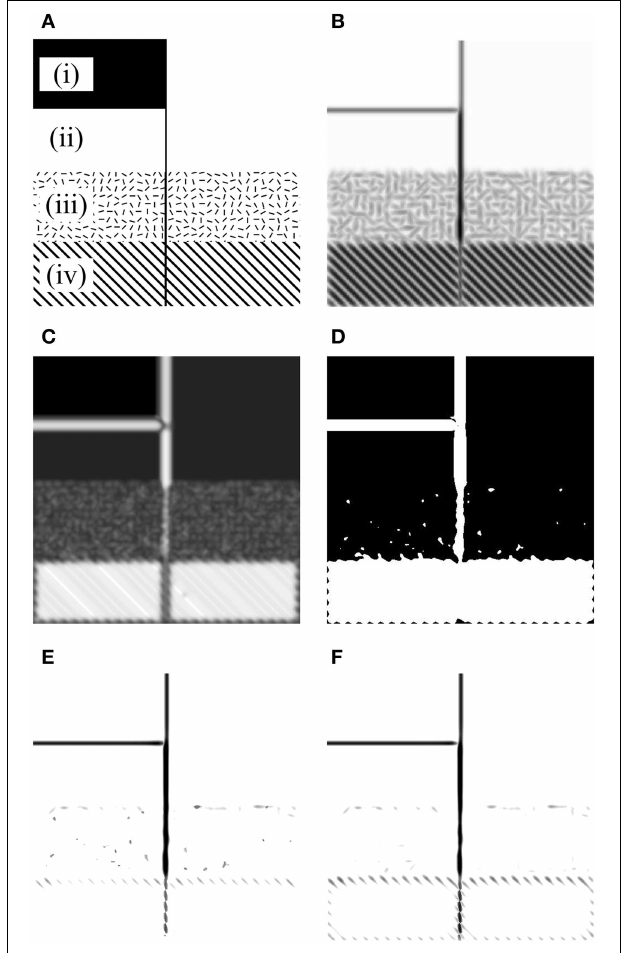
FIGURE 5 | Results of our models on a synthetic image. (A) Input image with four kinds of backgrounds [i.e., (i–iv)]. (B) The maximum Gabor energy map [darker pixels correspond to higher neuronal responses, which holds for (E,F) ]. (C) The real orientation-saliency (ROS) map defined by Equation (15) (whiter pixels correspond to higher orientation-saliencies). (D) The binary orientation-saliency (BOS) map defined by Equation (16) with th = 0 . 4 (white and black areas denote respectively the orientation-salient and non-orientation-salient regions). (E) The final output of Model 1 with α 1 = 1 . 60 and α 2 = 1 . 60 . (F) The final output of Model 2 with α 1 = 1 . 60 (in Equation 18) and α 2 = 2 . 56 (in Equation